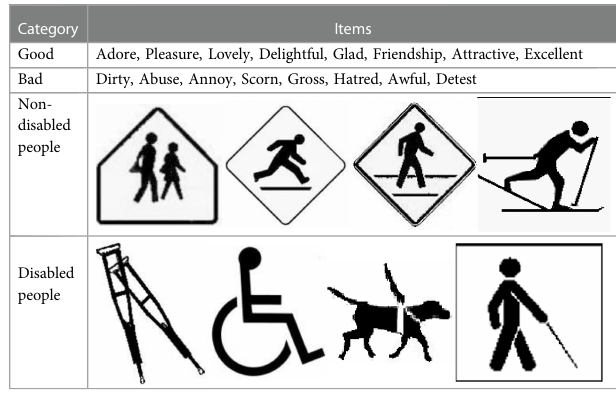
TABLE 1 Stimuli used for the disability